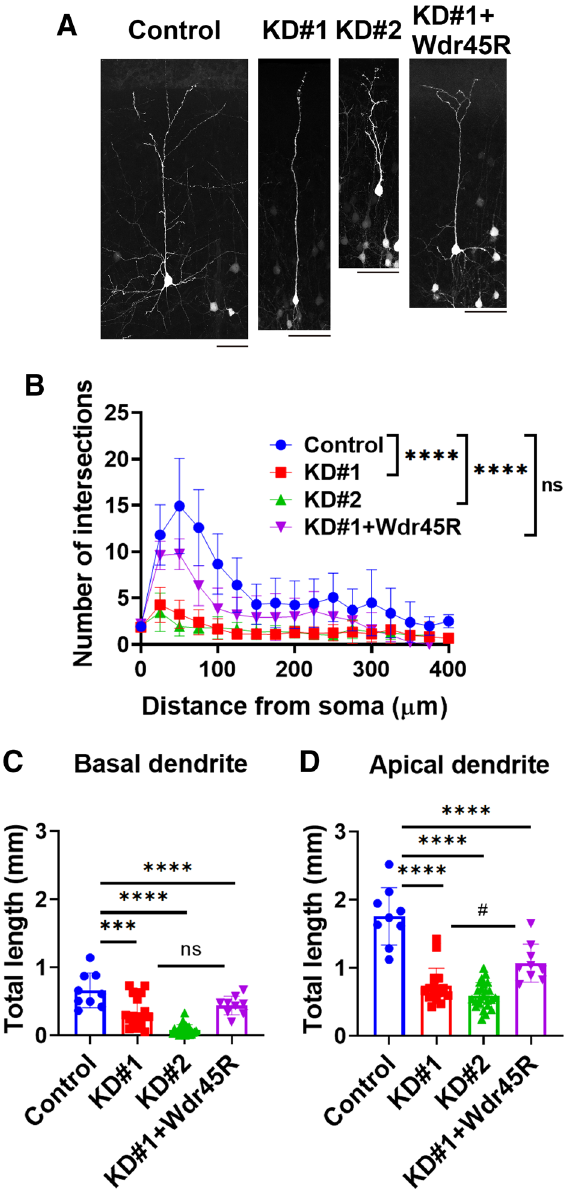
Figure 6. Effects of Wdr45-knockdown on dendrite growth in vivo. ( A ) For sparse expression, pCAG-loxP- GFP (0.5 µg) was co-electroporated with pCAG-M-Cre (1 ng) together with pSuper-H1.shLuc (control), pSuper-Wdr45#1, #2 or pSuper-Wdr45#1 plus pCAG-Myc-Wdr45R (1.5 µg each of pSuper vector and 0.5 µg of pCAG-Myc-Wdr45R) at E14.5. Coronal sections were prepared, stained for GFP and analyzed at P10. Representative average z-stack projection images of layer II/III cortical neurons were shown. Scale bars, 50 μm. ( B ) Branch points of dendrites in ( A ) were quantified by Sholl test. One section from each brain was analyzed for control (n = 3), KD#1 (n = 7), KD#2 (n = 6), and KD#1 + Wdr45R (n = 5). Error bars indicate SD of the results from 10 to 15 neurons; **** p < 0.0001, by one-way ANOVA with Dunnett’s post hoc test (vs. control). ( C,D ) Total length was calculated for basal ( C ) and apical dendrites ( D ). # p < 0.05, *** p < 0.001 and **** p < 0.0001 (*vs control; # vs KD#1) by one-way ANOVA with Tukey’s post hoc